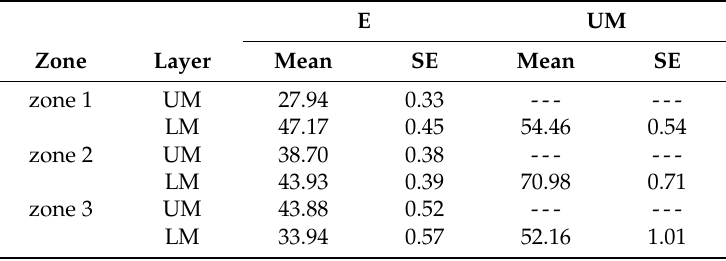
Table 2. The mean and standard error (SE) overlap of Bayesian ellipses between layers by the zones marked in Figure 1. Overlap is expressed as a fraction (%) of the non-overlapping area. E: epipelagic layer, UM: upper mesopelagic layer, LM: lower mesopelagic